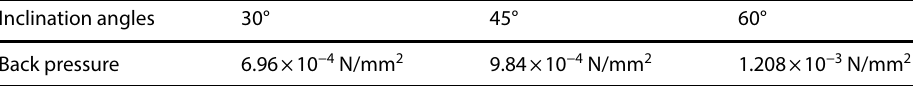
Table 3 Back pressure values corresponding to inclination